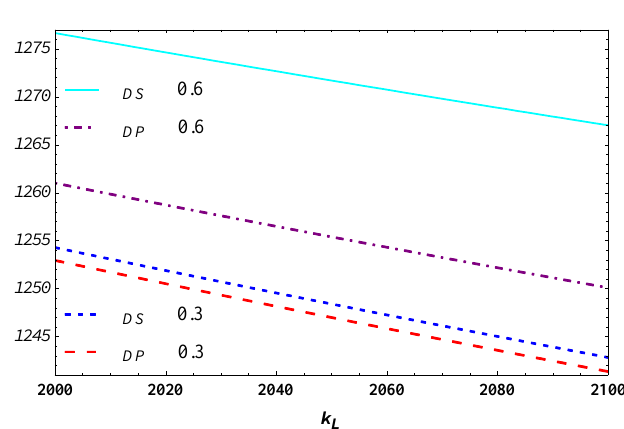
k on the designer’s profit. Figure 4. Influence of k H on the designer’s profit. Int. J. Environ. Res. Public Health 2018 , 15 , x H